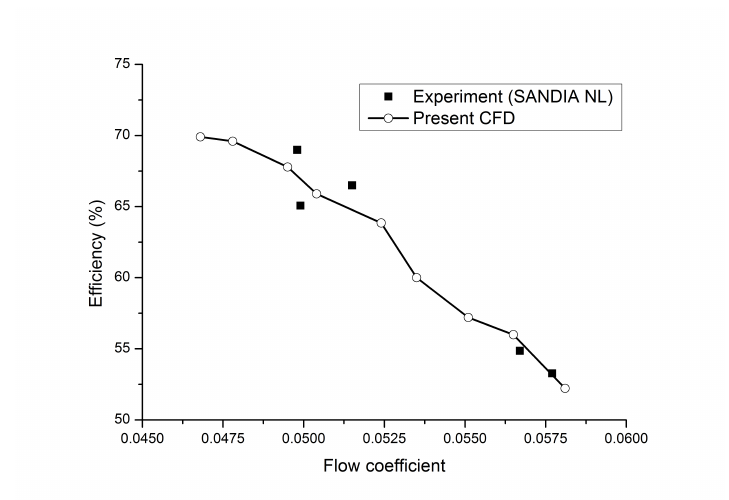
Figure 5. Comparison of present numerical results with the SNL experimental results [15] at inlet temperature of 309 K and pressure of 92 × 10 5 Pa.